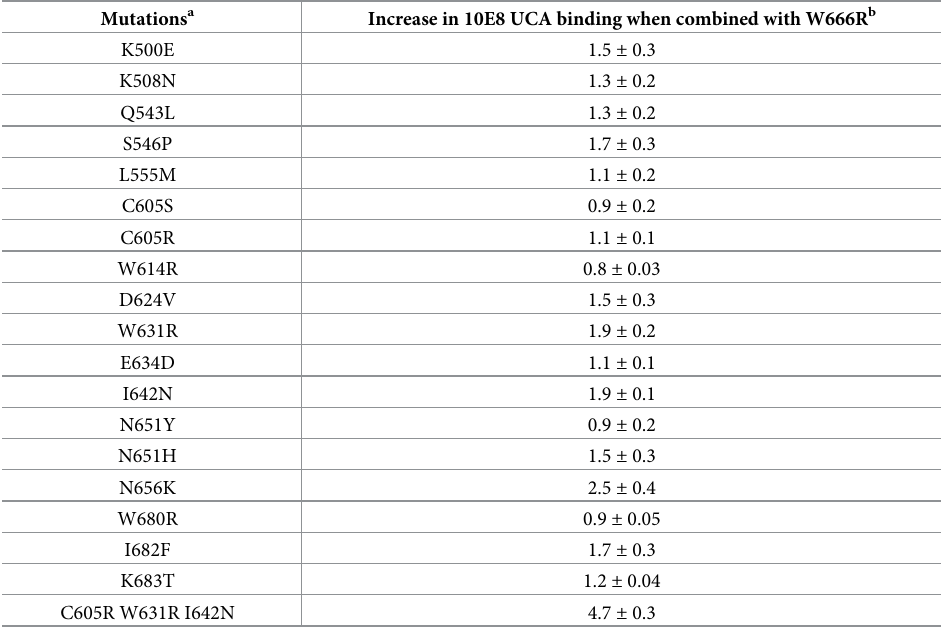
Table 6. Effects of combinations of amino acid substitutions on 10E8 UCA